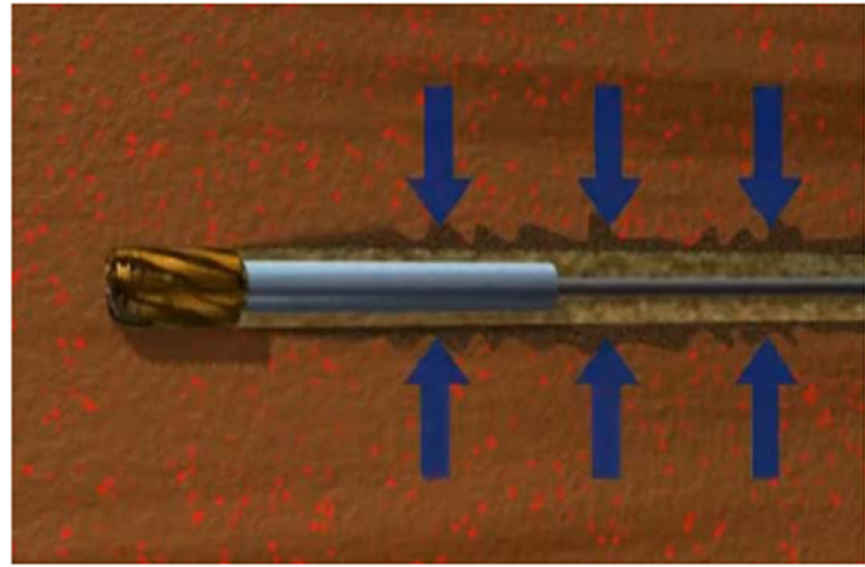
Figure 19. Underbalanced